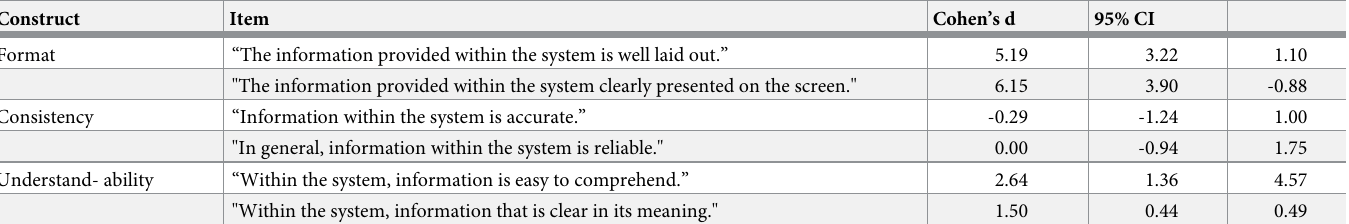
Table 4. Survey results of the effect size for comparison of representational information quality with current method using traditional reports and the software using